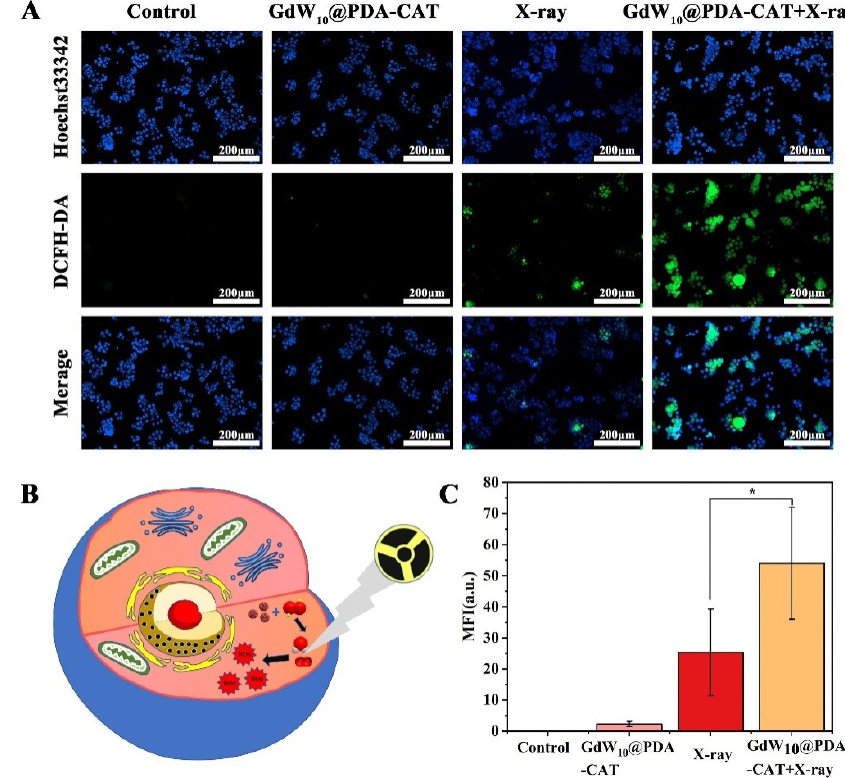
Figure 6. The production of ROS in vitro. ( A ) Fluorescence images for ROS generation in HT29 cells stained by Hoechst33342 and DCFH-DA after various treatments. The scale bar is 50 μ m. ( B ) Schematic diagram of ROS produced by ionizing radiation. ( C ) Quantitative analysis of FITC in cells with different treatments. The p Values were calculated by the Student’s t test: *, p <